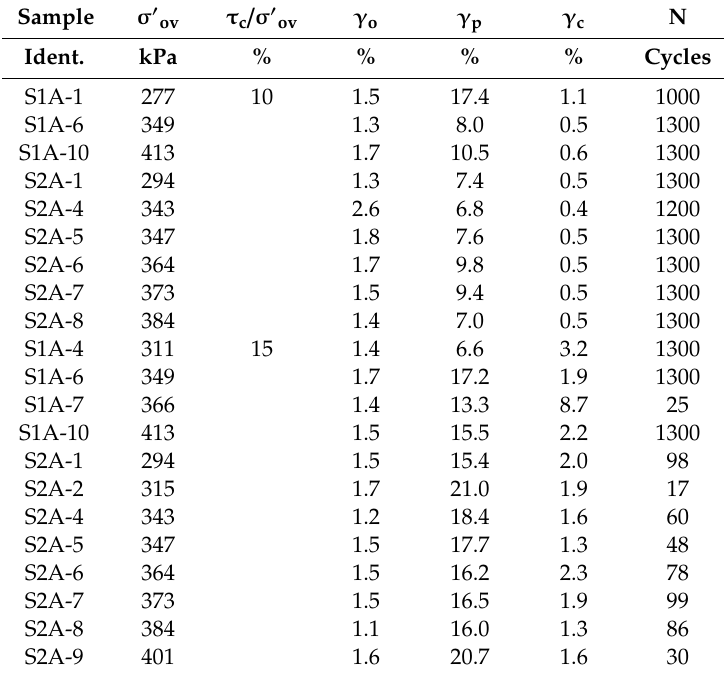
Table 7. Results of cyclic simple shear test with τ o / σ (cid:48) ov = 15%.